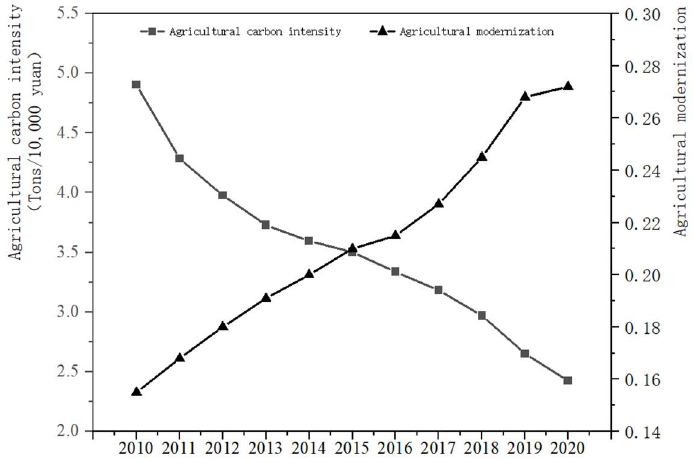
Figure 3. Temporal characteristics of agricultural carbon emission intensity and agricultural modernization level. Source: Authors’ calculations. Same below.